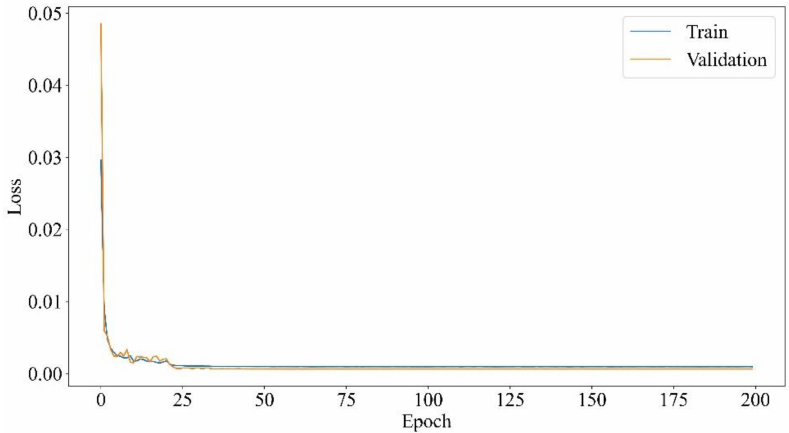
Figure 8. MSE loss of the proposed ILRCN model with the number of epochs.